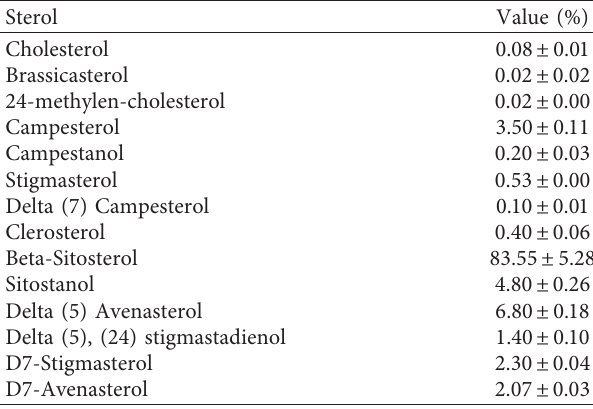
Table 4: Sterol composition of sour cherry kernel oil.